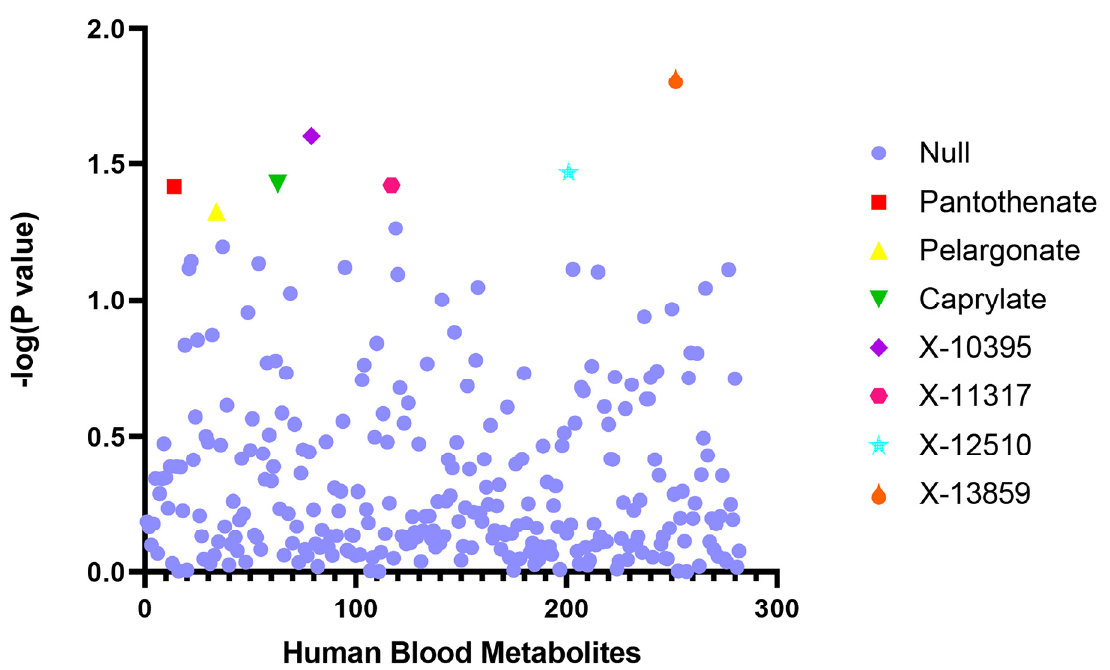
Figure 1. Genetic correlation analysis between spondyloarthritis and blood metabolites. Abscissa: the number of blood metabolites. Ordinate: p -value of the linkage disequilibrium score regression results. Null: The linkage disequilibrium score regression showed the blood metabolites that had no genetic correlation with spondyloarthritis ( p -value > 0.05).